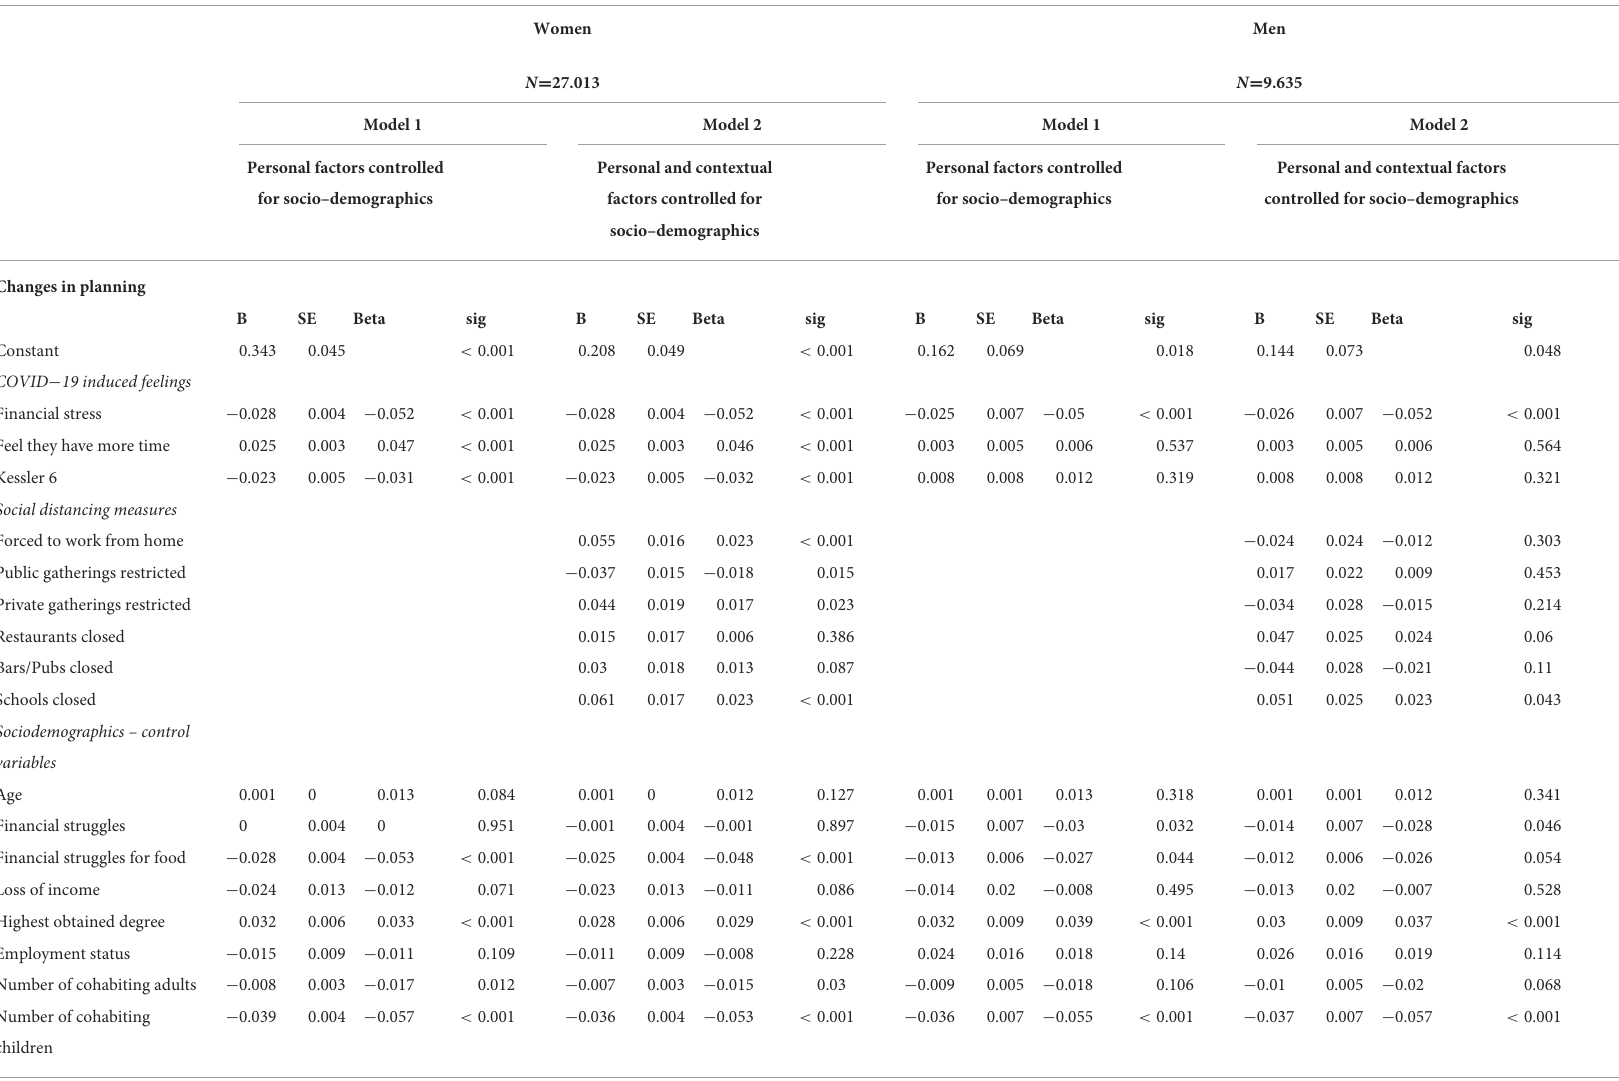
SUPPLEMENTARY TABLE 2 Detailed overview of all results from the Hierarchical Multiple Regression a of the effects of COVID − 19 induced personal and contextual factors on changes in planning. selecting. and preparing healthier foods ( N = 37.207) b